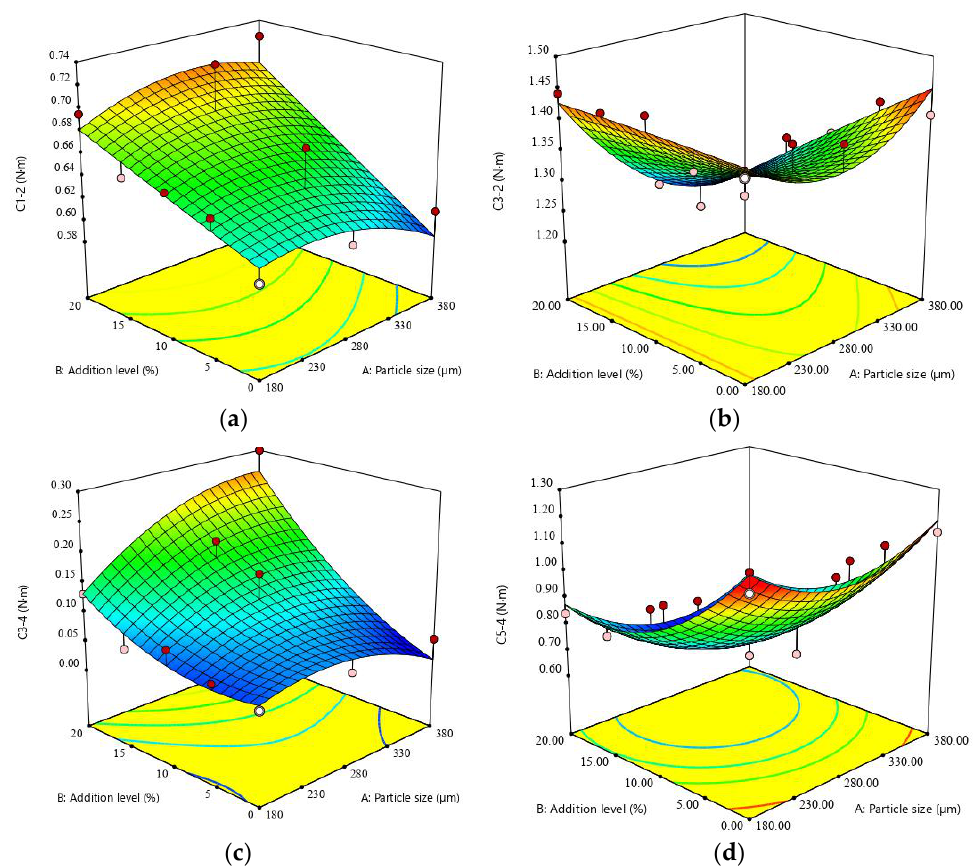
Figure 2. Response surface graphic of ( a ) protein weakening (C1-2), ( b ) starch gelatinization (C3-2),